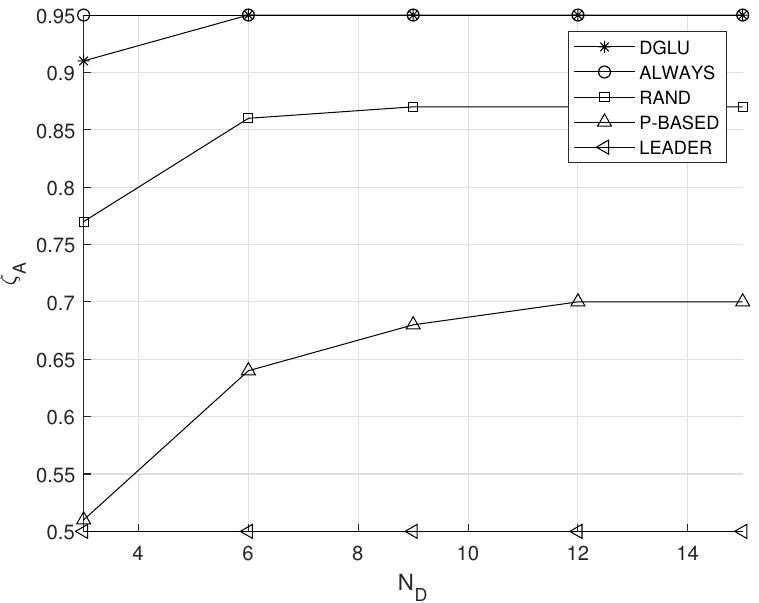
Figure 8. Effect of the number of IoT devices in one group N D on the average location accuracy ζ A